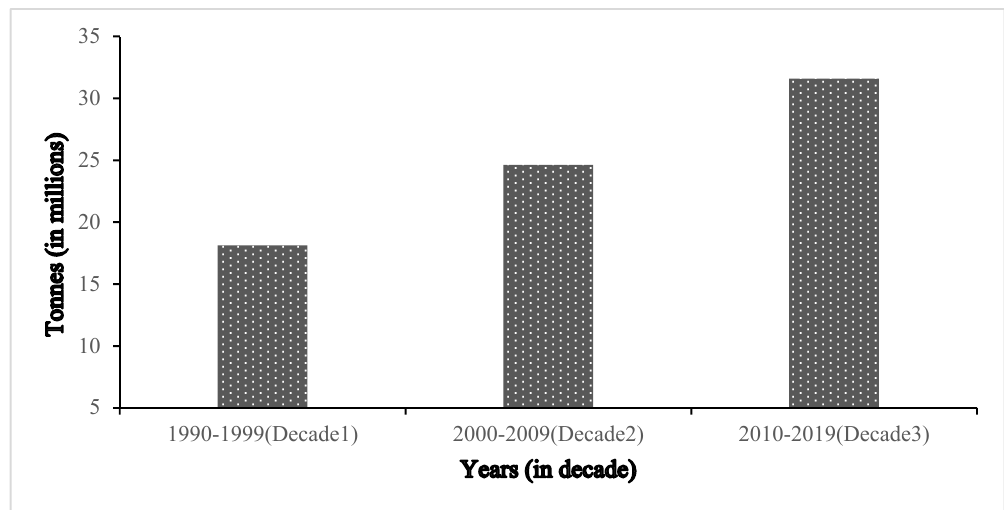
Figure 2. Total wood charcoal production in Africa from 1990 to 2019. Sources: Authors’ compilation, analysis and mapping from FAOSTAT database.